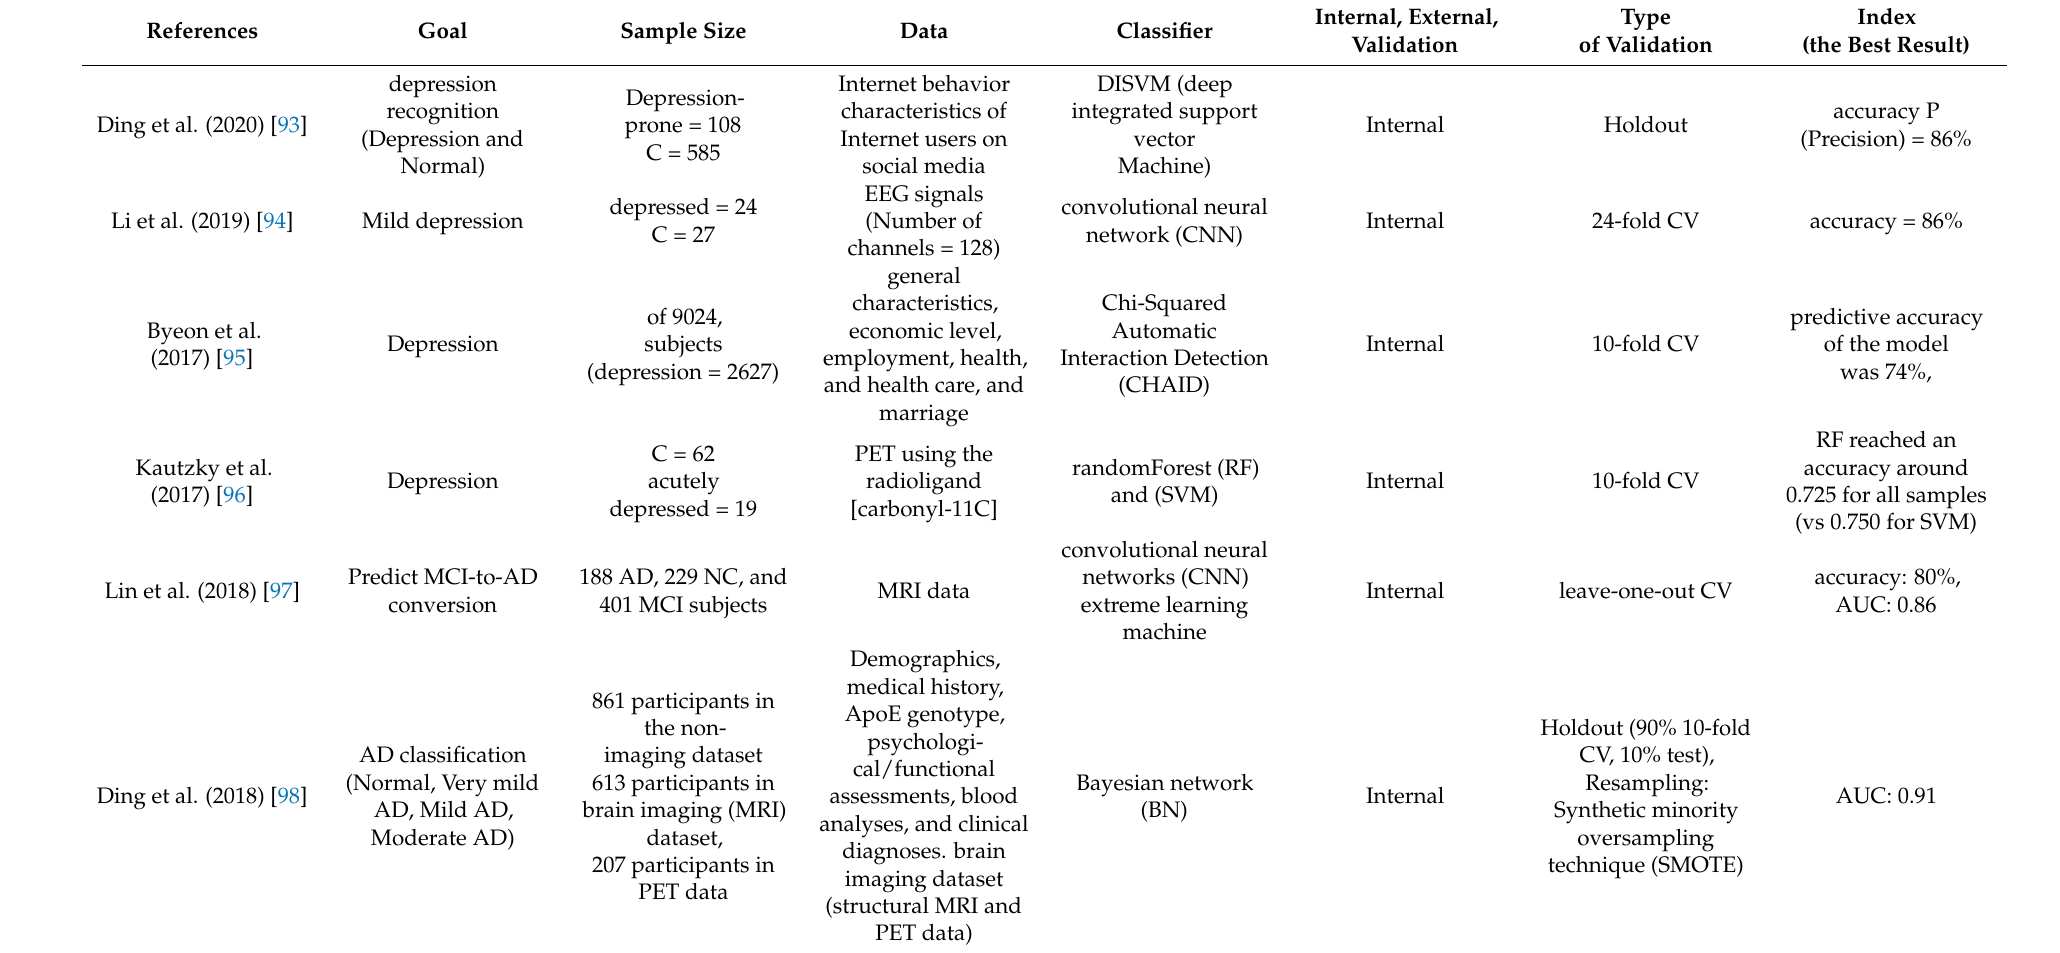
Table 5. CAD methods for mental and neurological disorders